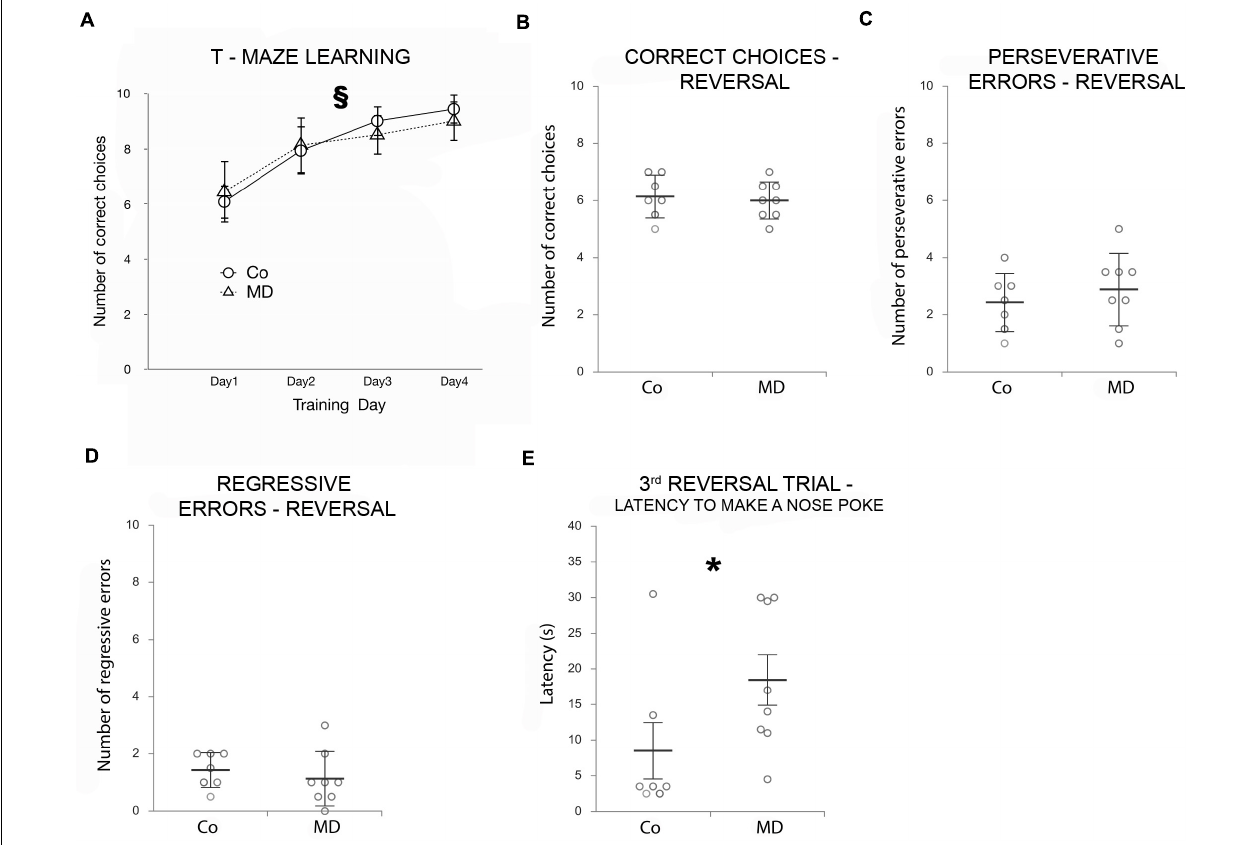
Frontiers in Behavioral Neuroscience |